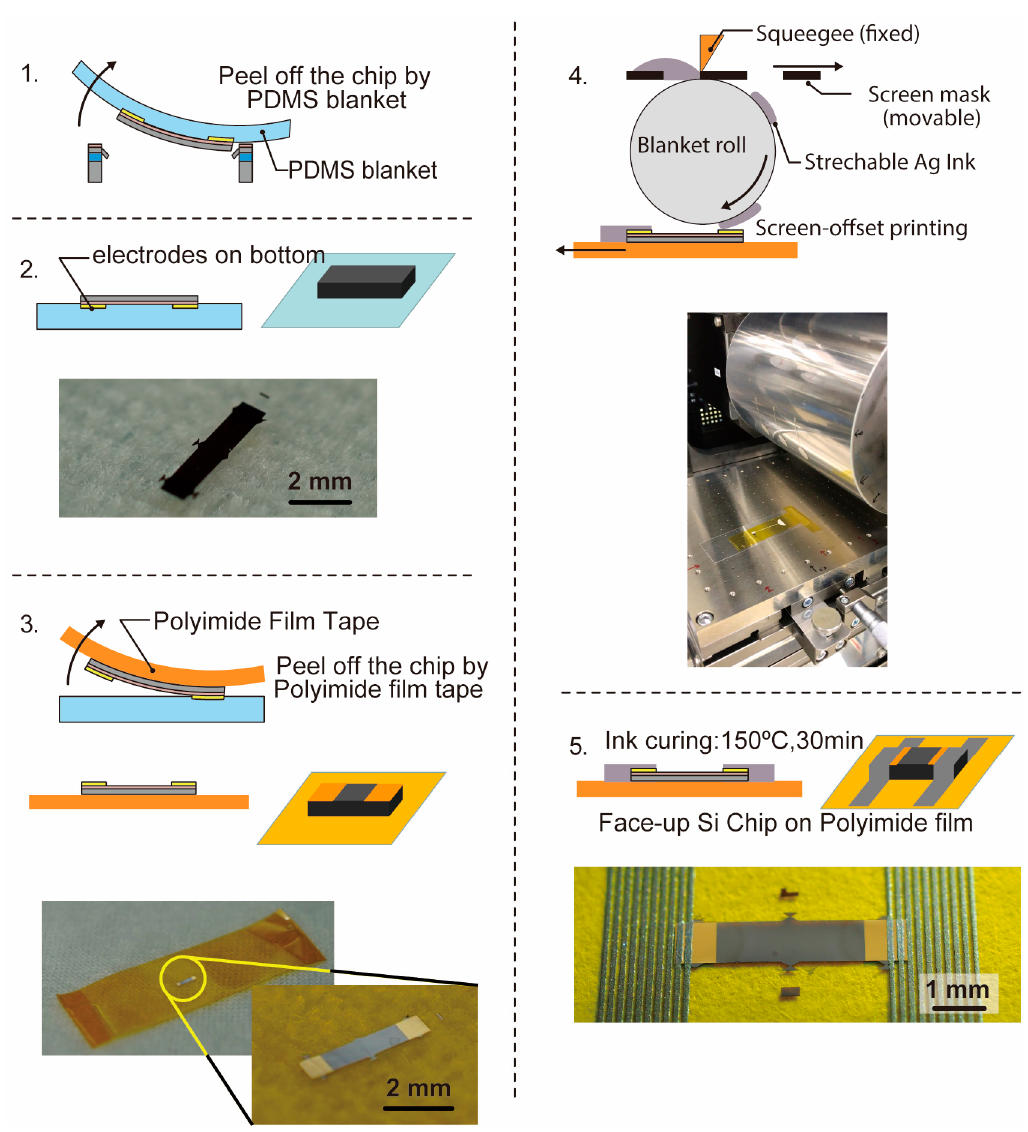
Figure 4. Process outline of transferring the face-up ultrathin Si chip and wiring on a polyimide film tape using screen-offset printing.